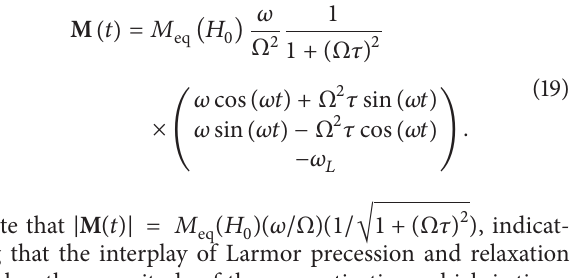
Figure 2: (colour online) Equilibrium magnetization ( L ) and approximate equilibrium magnetization (𝑅) calculated for 𝑡 = 7𝑇/8 and 𝑡 = 𝑇 ( L max & 𝑅 max ) plotted against the amplitude 𝐻 0 of the AC magnetic field. At 𝑡 = 𝑇 the two are identical by definition of 𝜒 , but at 𝑡 = 7𝑇/8 the relative difference between the L and 𝑅 ch curves increases with 𝐻 0 , reaching 20 % at 100 kA/m.